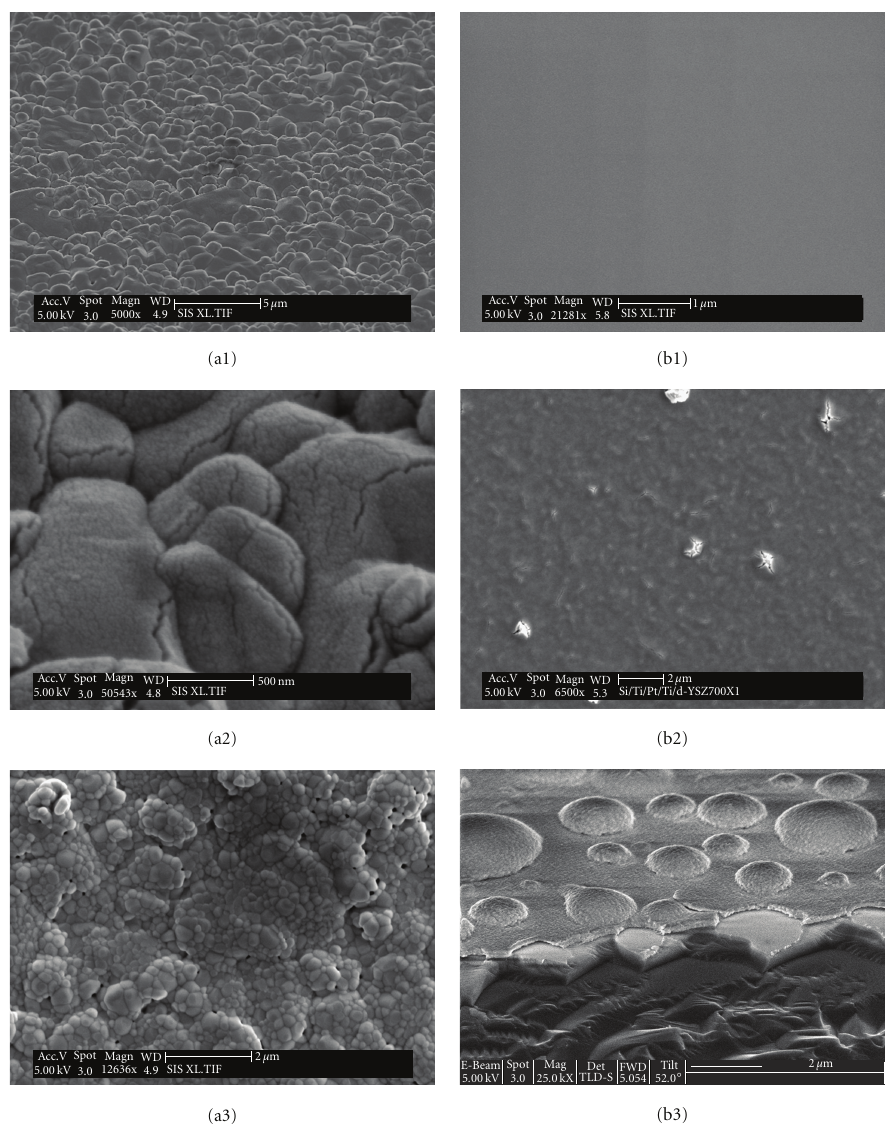
Figure 2: SEM images of di ff erent thin films deposited on dense polycrystalline alumina plate (a series) and on silicon wafer (b series). (a1, b1) as-sputtered, (a2, b2) annealed at 800 ◦ C, and (a3, b3) annealed at 1200 ◦